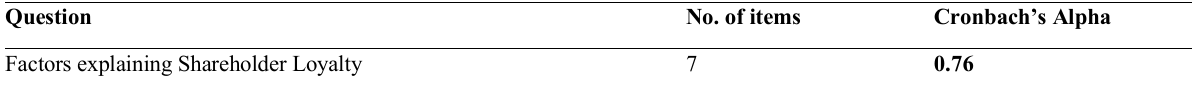
Table 4: Cronbach’s alpha on shareholder